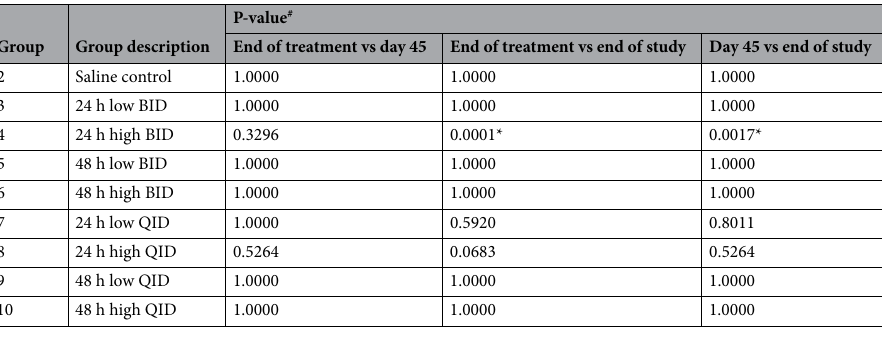
Table 2. P-values from Boschloo’s tests comparing survival proportions between each pair of timepoints within each group. Statistical comparison of survival proportions within the control and each treated group at specific stages post-treatment including the end of treatment, 30 days post-cessation of treatment (Day 45), and the end of study. The survival rate of the 24 h high dose BID treated group was significantly less at the end of study compared to the end of treatment and Day 45, illustrating twice daily treatment likely does not meet the required threshold of % f T > *4MIC to adequately clear infection as significant changes in survival rate were not observed in the low dose and high dose QID treated groups at the same time points. # P-value is for two-sided Boschloo’s test comparing survival rates between each pair of timepoints within each group. Overall error rate of the three tests is controlled at 5% using the Bonferroni-Holm multiple comparison procedure. *Survival rates are significantly different between the timepoints.